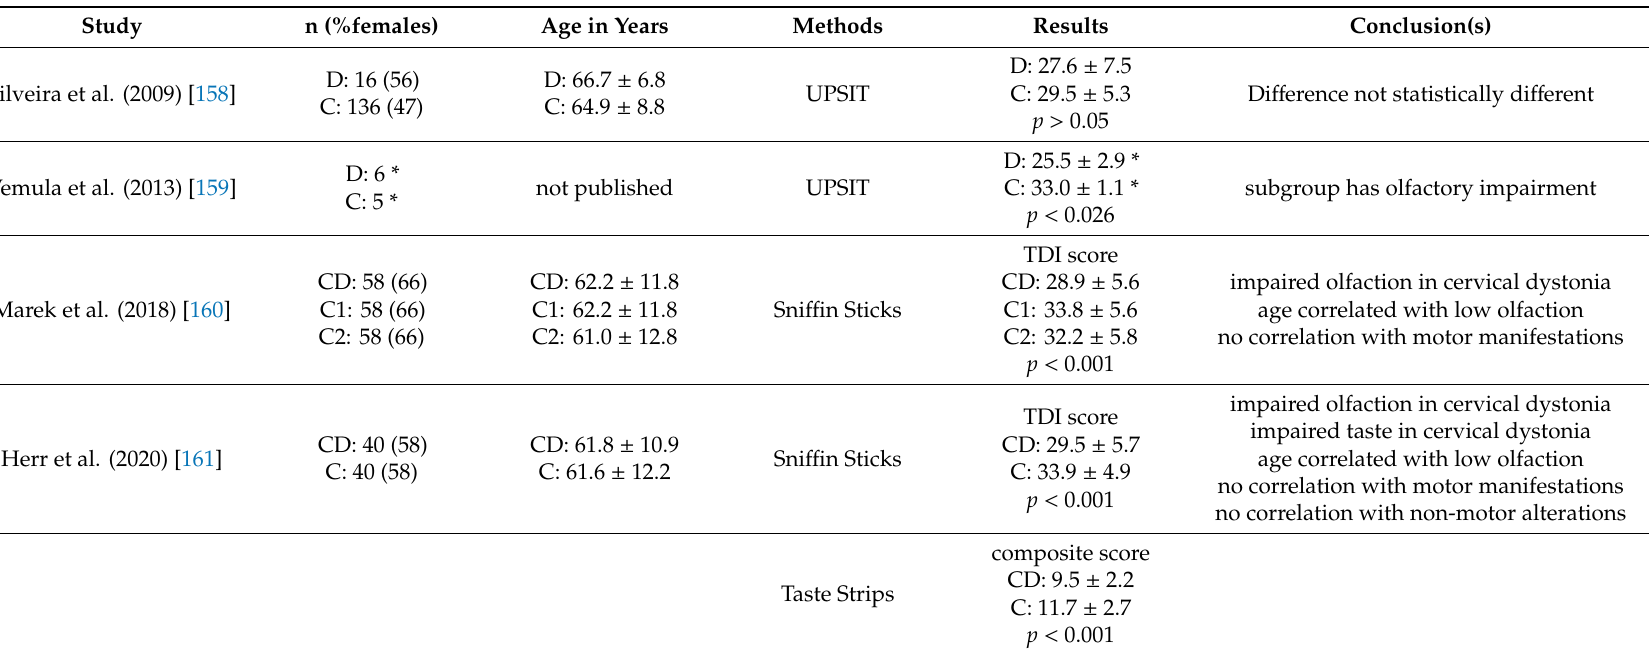
Table 1. Summary of publications on olfaction in